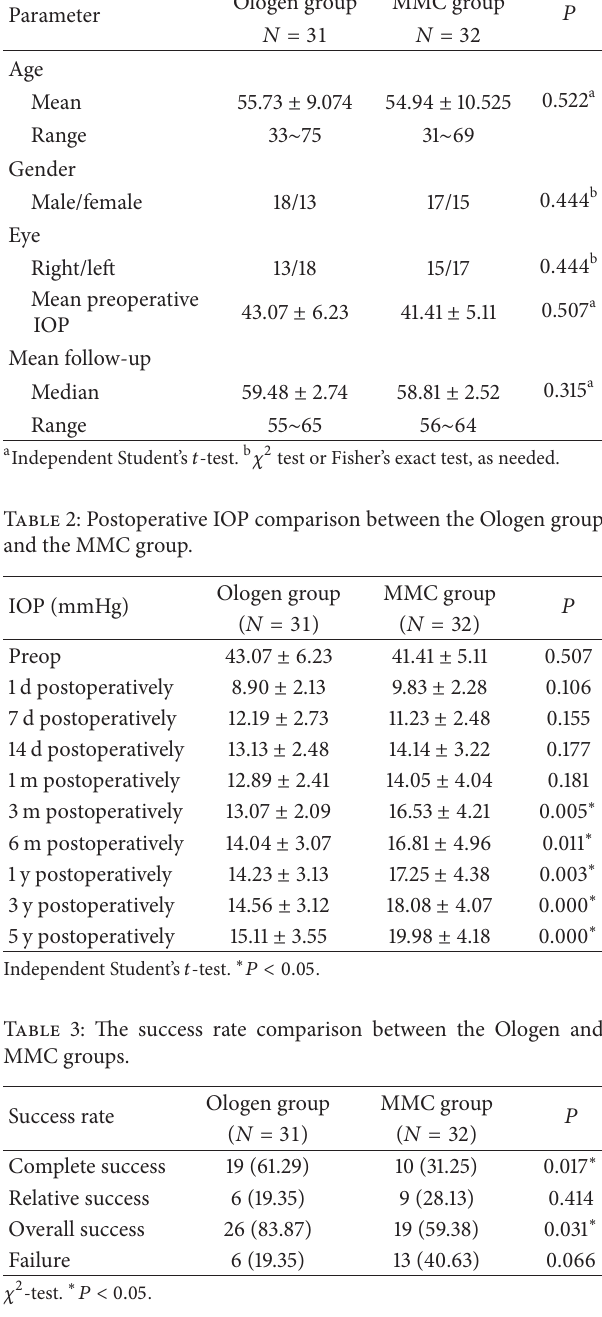
Table 4: Comparison of complications between the Ologen group and MMC group.